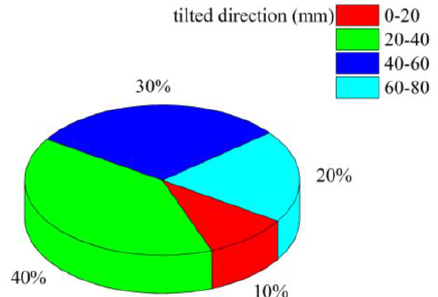
Figure 10. A 3D pie graph of the columns on the third floor